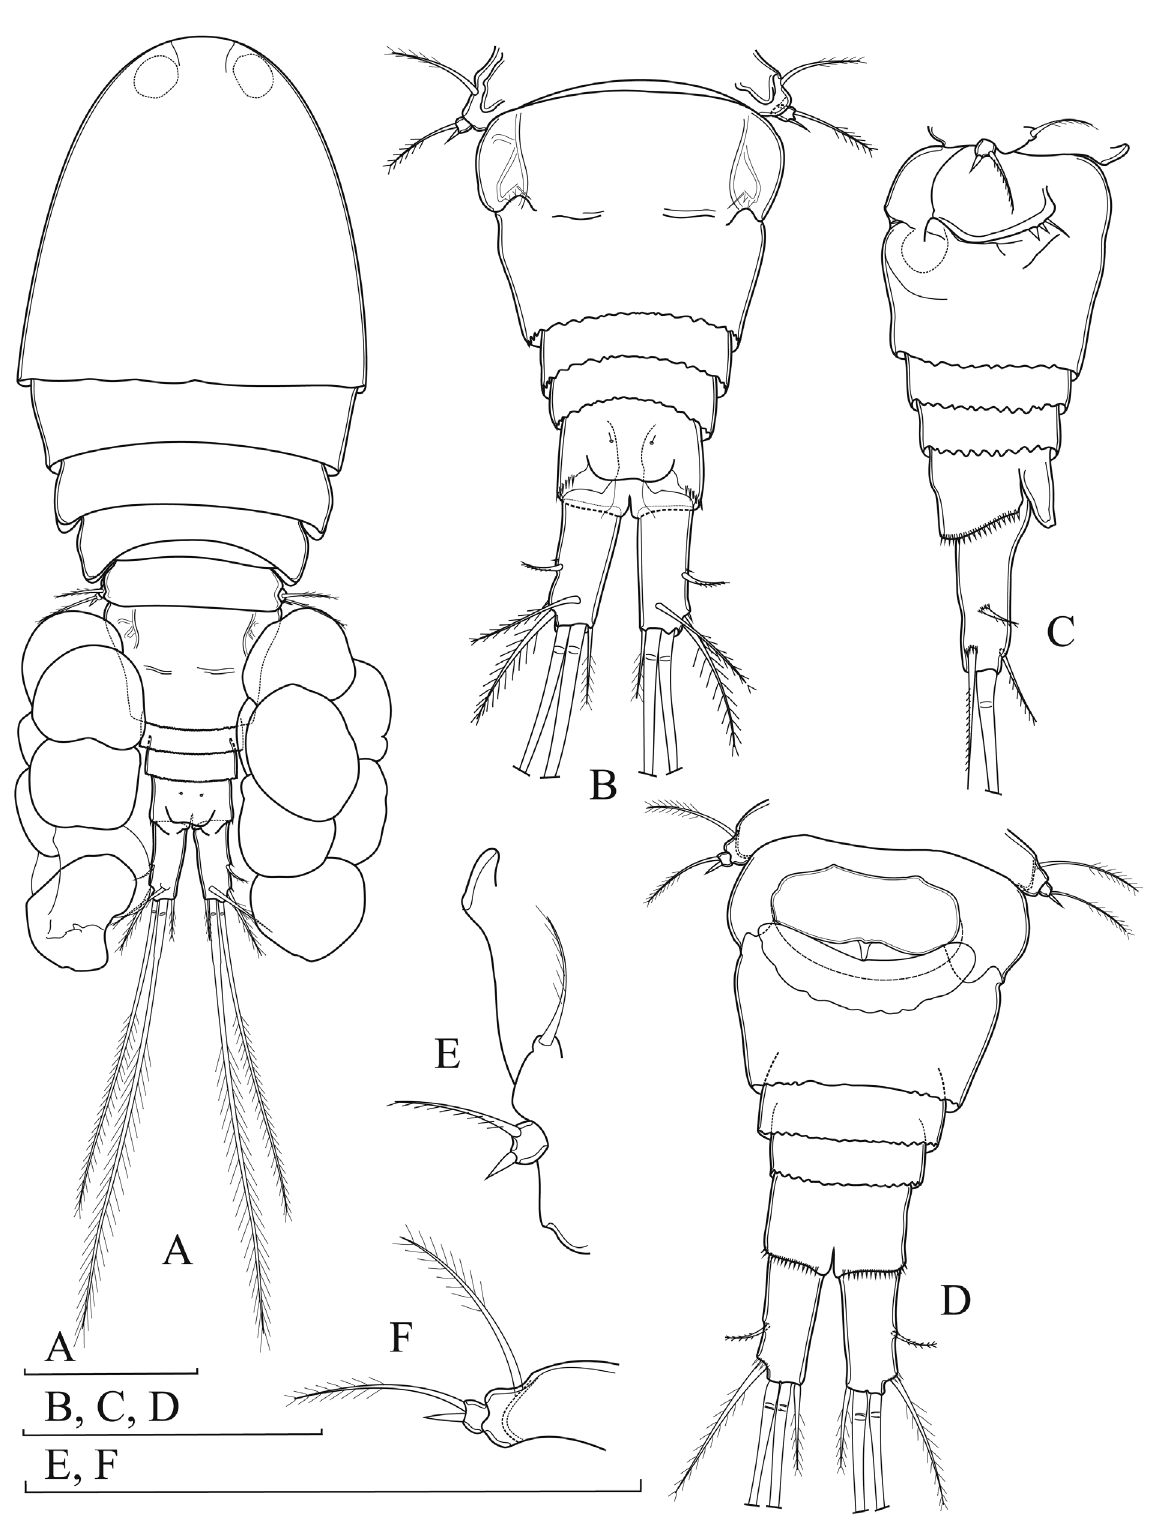
Fig. 6. Metacyclops thailandicus sp. nov., holotype, ♀. A . Habitus, with egg sac, dorsal view. B . Urosome, dorsal view. C . Urosome, lateral view. D . Urosome, ventral view. E . P5, lateral view. F . P5, ventral view. Scale bars: 100